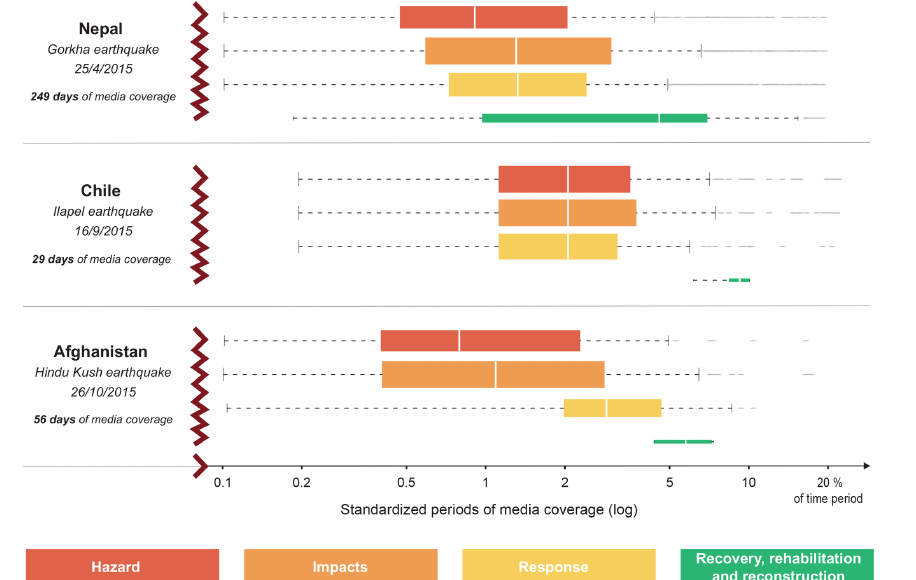
Figure 5. Temporal distribution of the DRM categories in the media coverage of the three main earthquakes in 2015. The height of the boxes is proportional to the number of news items (for each earthquake). The beginnings and ends of the boxes correspond to the first and third quartiles, respectively. The white lines inside the boxes correspond to the median